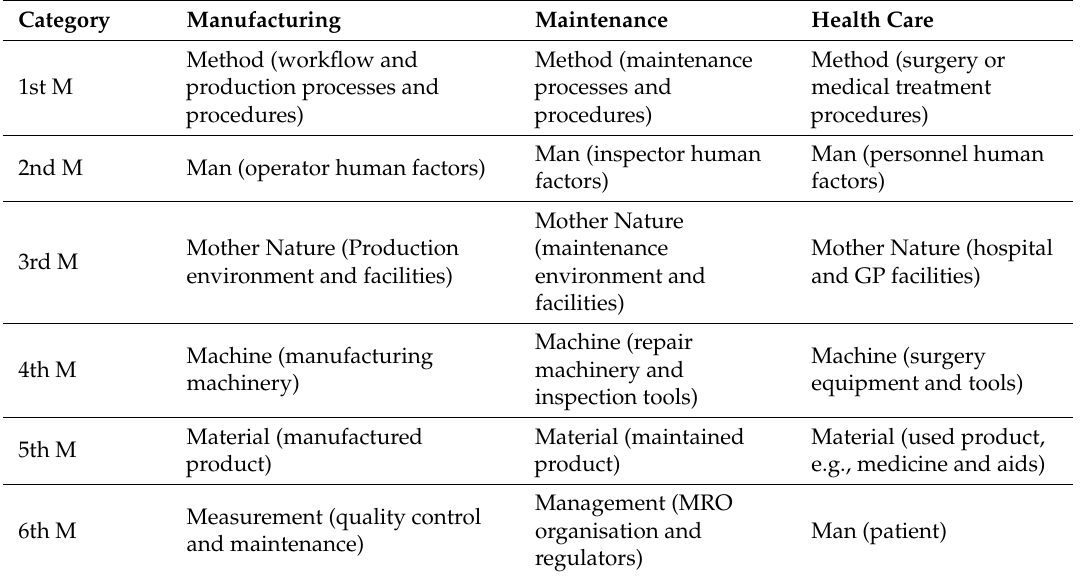
Table 1. Contextualisation of the 6M categories to di ff erent industries.